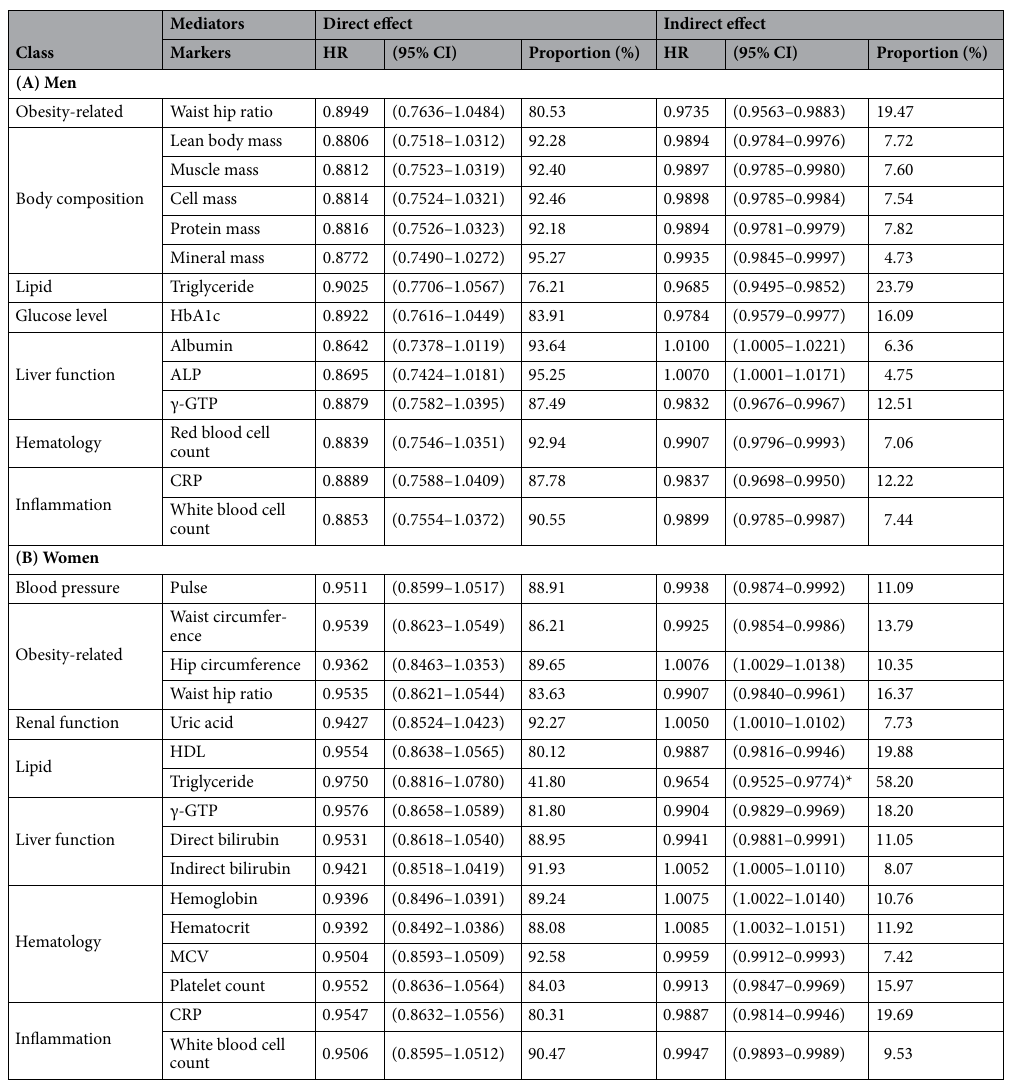
Table 2. Direct and indirect effects of regular exercise on the risk of any cardiovascular & metabolic disease (no. of disease ≥ 1). (A) Age as time scale and adjusted for education level, income, marital status, occupation, smoking status, drinking status, and BMI. ALP, alkaline phosphatase; γ-GTP, γ-glutamyl transpeptidase; CRP, C-reactive protein. (B) Age as time scale and adjusted for education level, income, marital status, occupation, smoking status, drinking status, BMI, and menopause status. HDL, high density lipoprotein-cholesterol; γ-GTP, γ-glutamyl transpeptidase; MCV, mean corpuscular volume; CRP, C-reactive protein. *FDR p value <